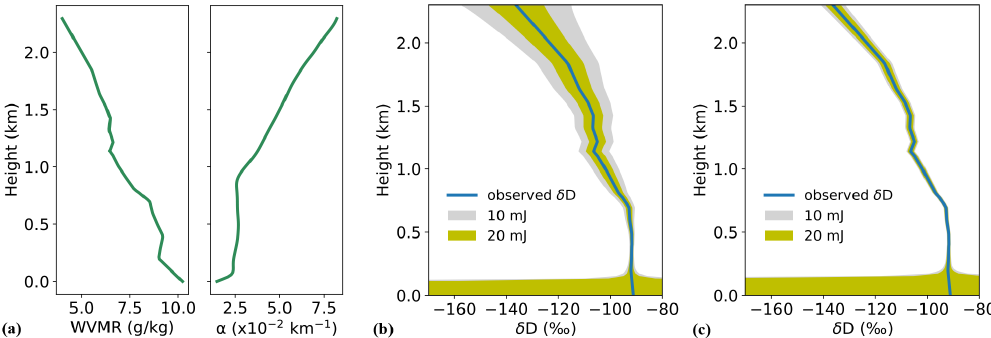
Figure 9. (a) Experimental profiles of the water vapor mixing ratio (WVMR) and aerosol extinction coefficient ( α ) obtained from the L- WAIVE field campaign. Expected precision in the isotopic ratio in terms of δD for the InGaAs PIN photodetector (b) and the low-noise HgCdTe avalanche photodiode detector (c) . Shaded areas indicate the absolute uncertainty based on random noise in terms of standard deviation for laser energies of 10 and 20mJ. High uncertainty in the first 200m is due to low signal caused by the overlap function increasing from zero to unity (see Eq. 2). Calculations are based on a measurement bandwidth of 1MHz (150m spatial resolution) and an integration time of